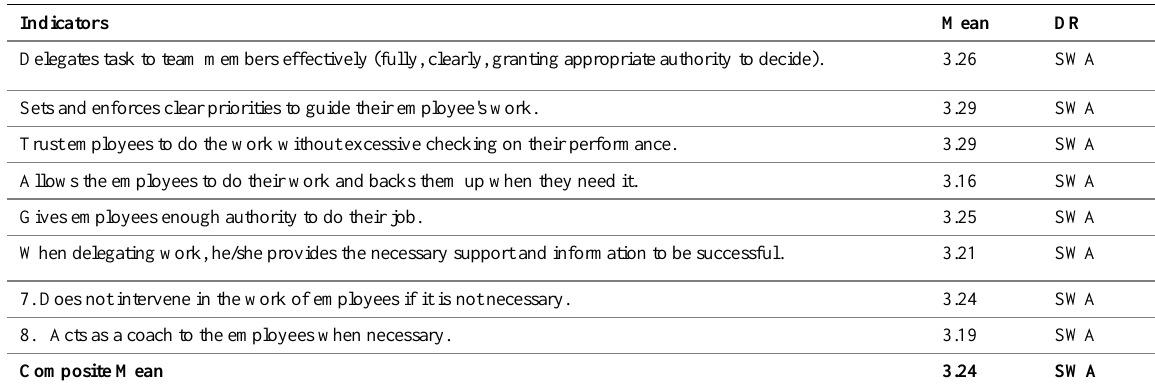
Table 6: The Leadership Skills of Office Heads of Divine Word Colleges in the Ilocos Region in terms of Delegation and Empowerment Indicators Mean